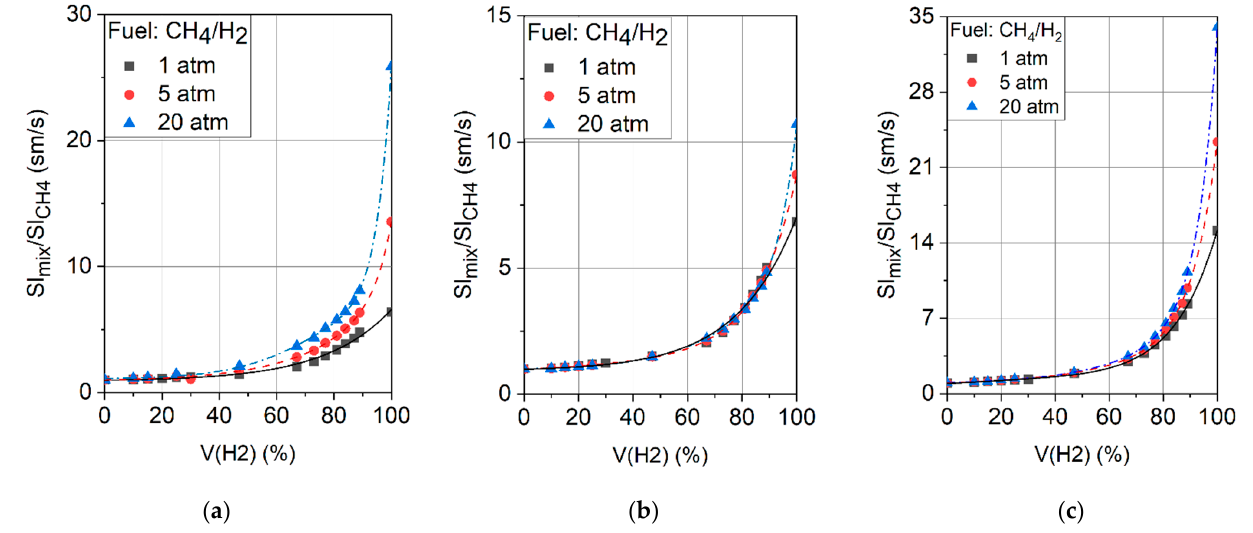
Figure 4. Relationship between the propagation laminar flame speed of methane–hydrogen mixture and the volume concentration of hydrogen [9,11,12] ( a ) ϕ = 0.6; ( b ) ϕ = 1; ( c ) ϕ = 1.4.